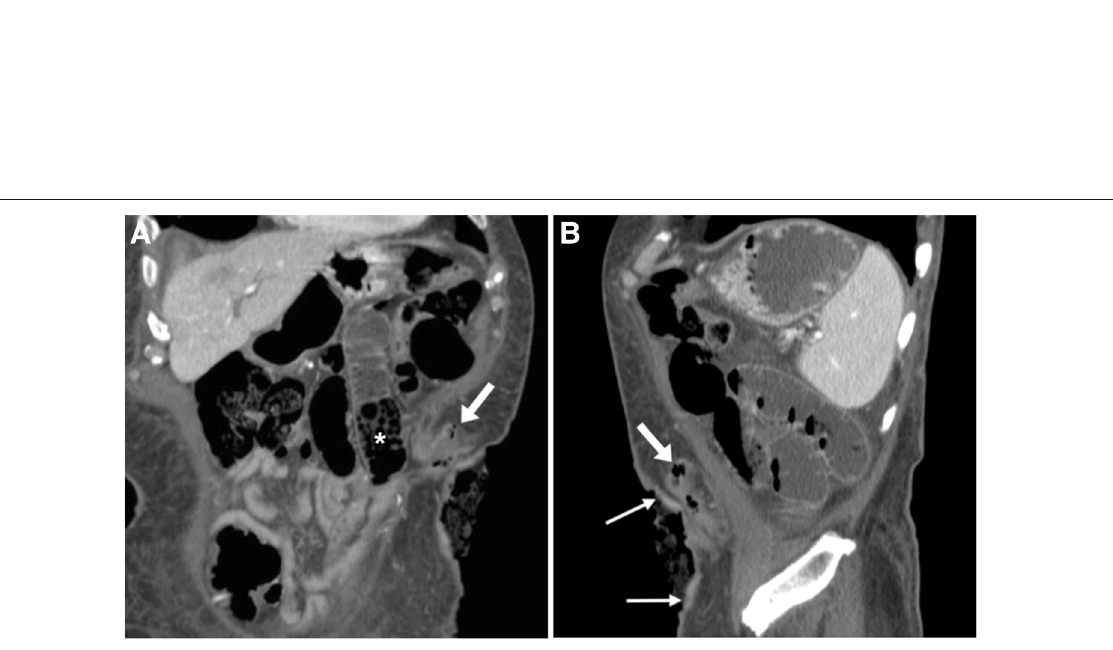
Fig. 9 Stoma retraction appearing as depressed, thickened and irregular skin (thin arrows) at the site of a descending colostomy with elongated collapsed tract (arrows). Note distended small bowel loops with feces (*) consistent with obstruction